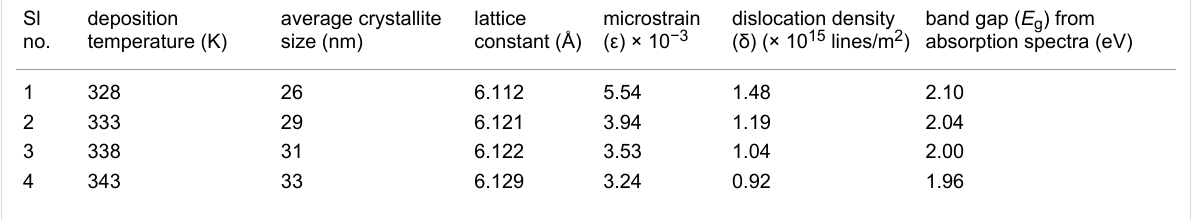
Table 1: Structural parameters and band-gap energies of PbSe thin films deposited at different temperatures. Sl